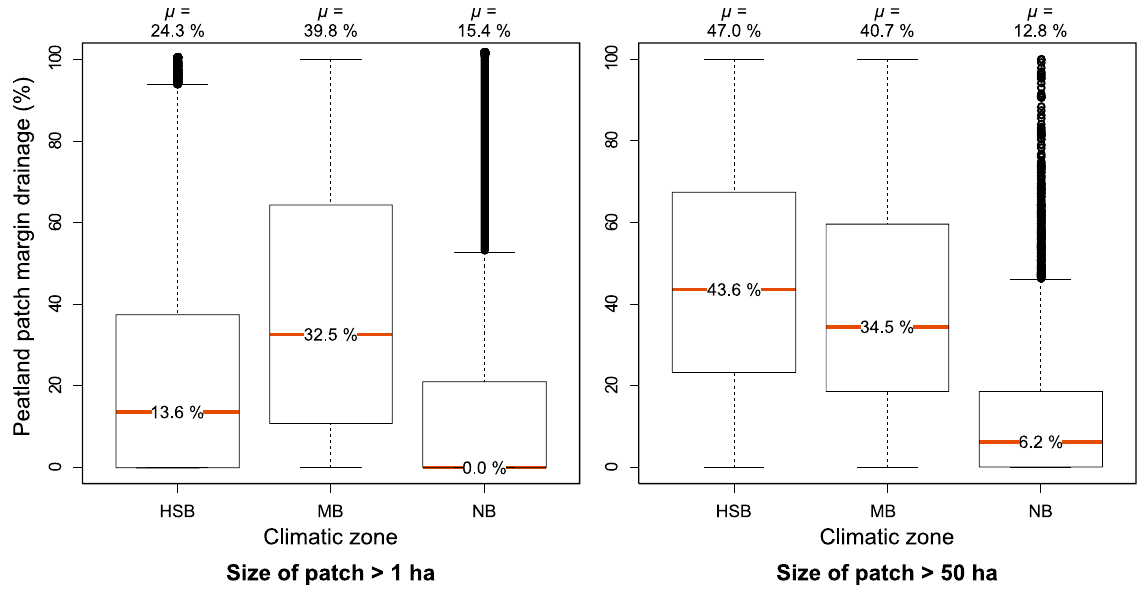
Figure 6. Drained proportion (%) of the margin length of undrained peatland patches in Finland. Left: minimum area 1 ha (N = 219,201); right: minimum area 50 ha (N = 7,002). Medians are shown on the median lines and means are above the diagram. HSB = hemiboreal and southern boreal zone, MB = middle boreal zone, NB = northern boreal